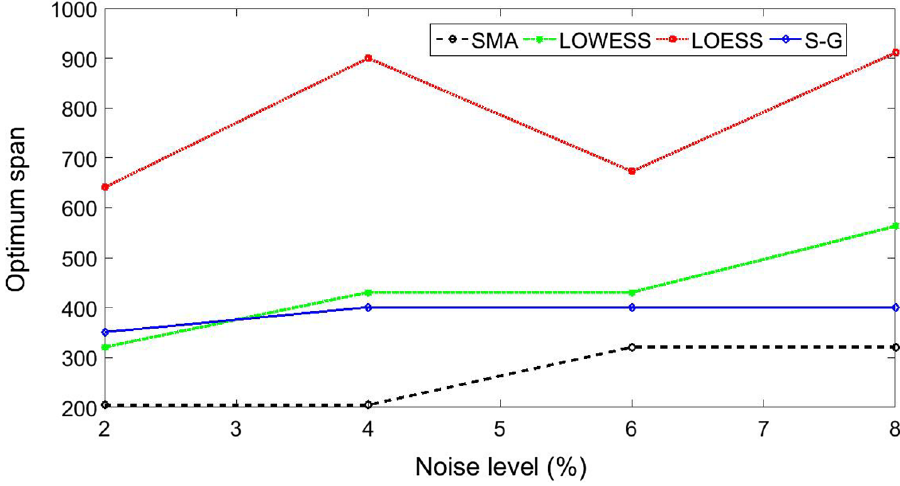
Fig. 7 Optimum spans versus noise percentages for various regressive smoothing